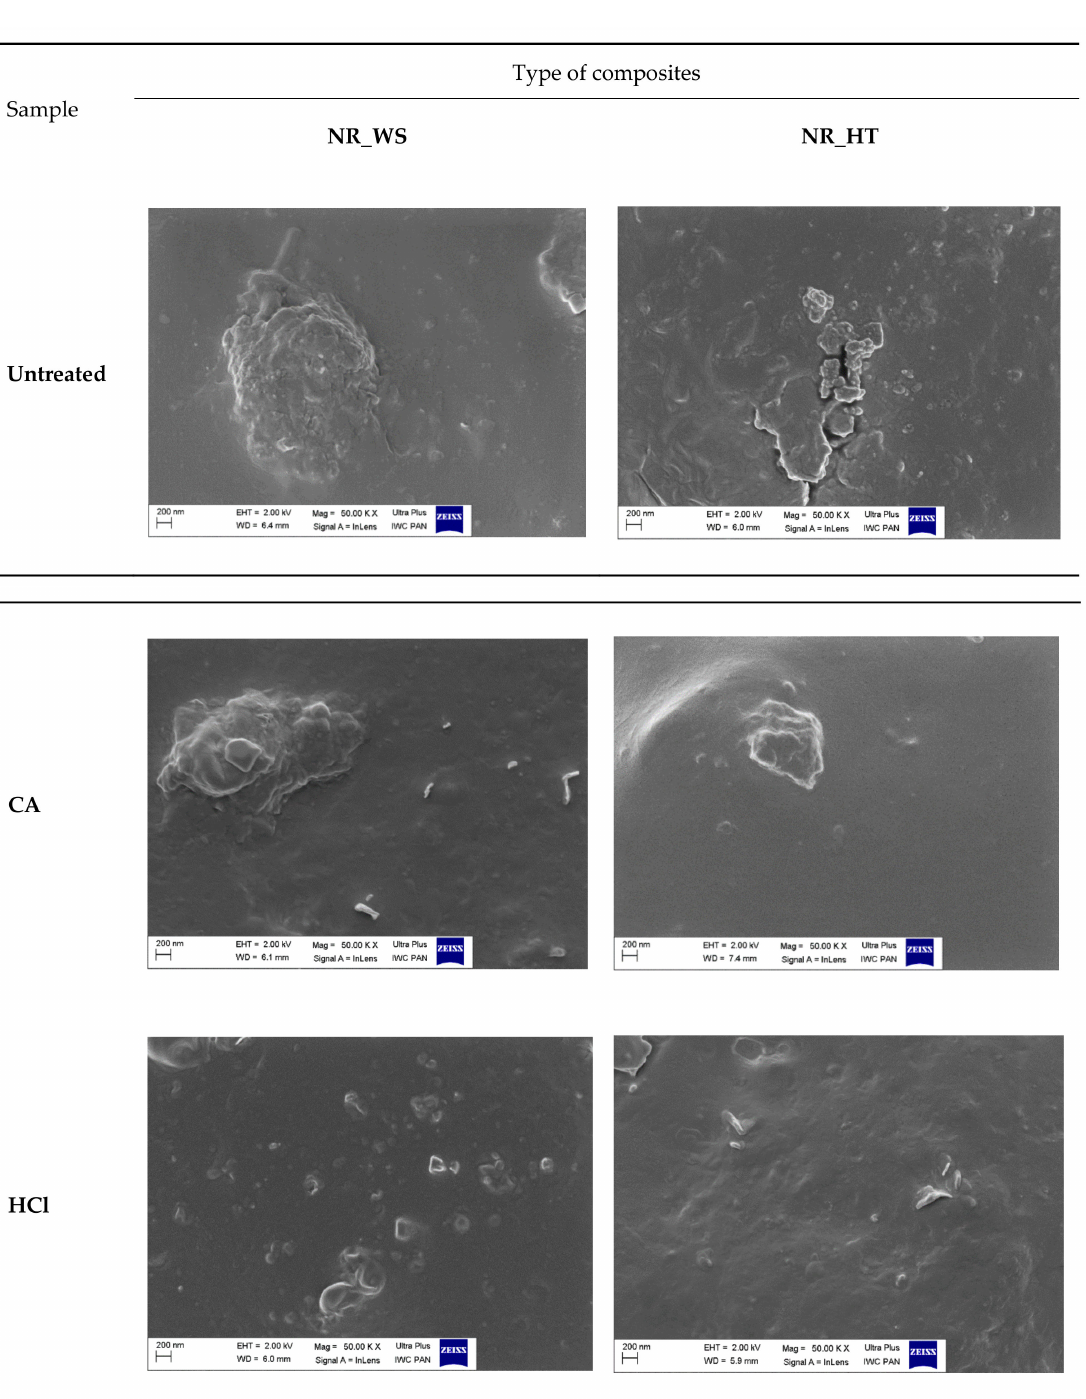
Figure 10. SEM images of natural rubber vulcanizates filled with